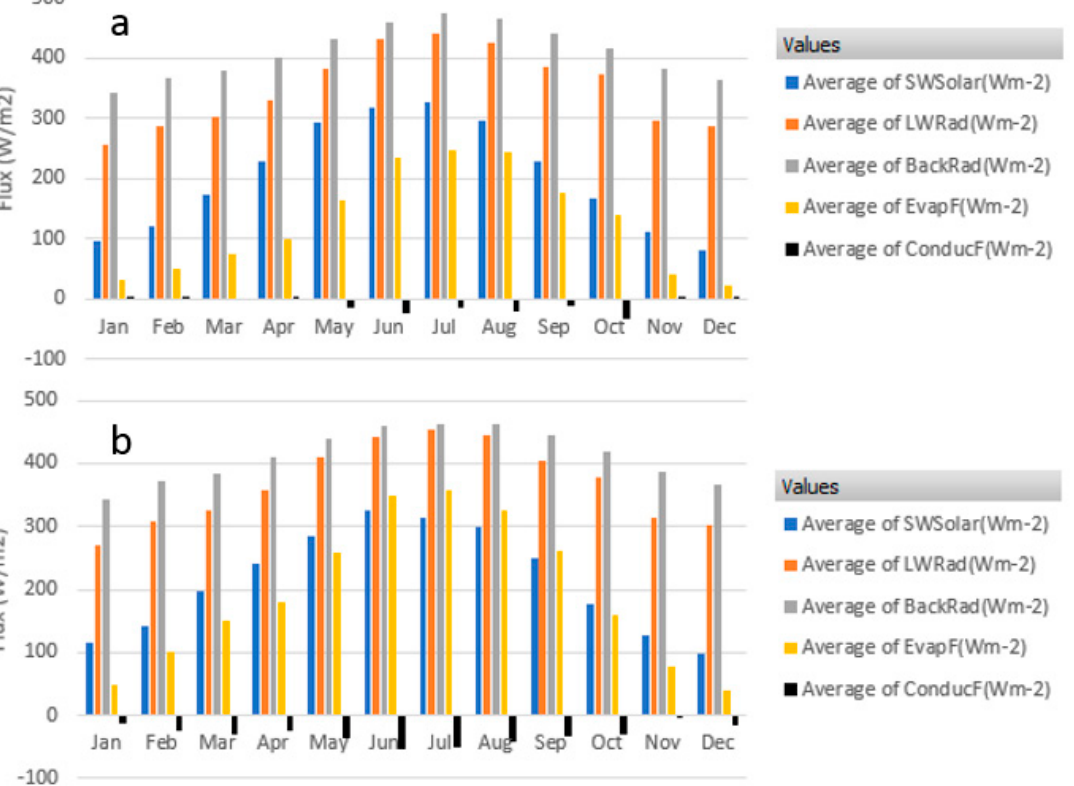
Figure 10. W2 model predictions of monthly average heat fluxes in the Tigris River at ( a )Baeji, ( b ) Baghdad. SWSolar: short-wave solar radiation, LWRad: long-wave atmospheric radiation, BackRad: back radiation, EvapF: evaporation, and ConducF: conduction.